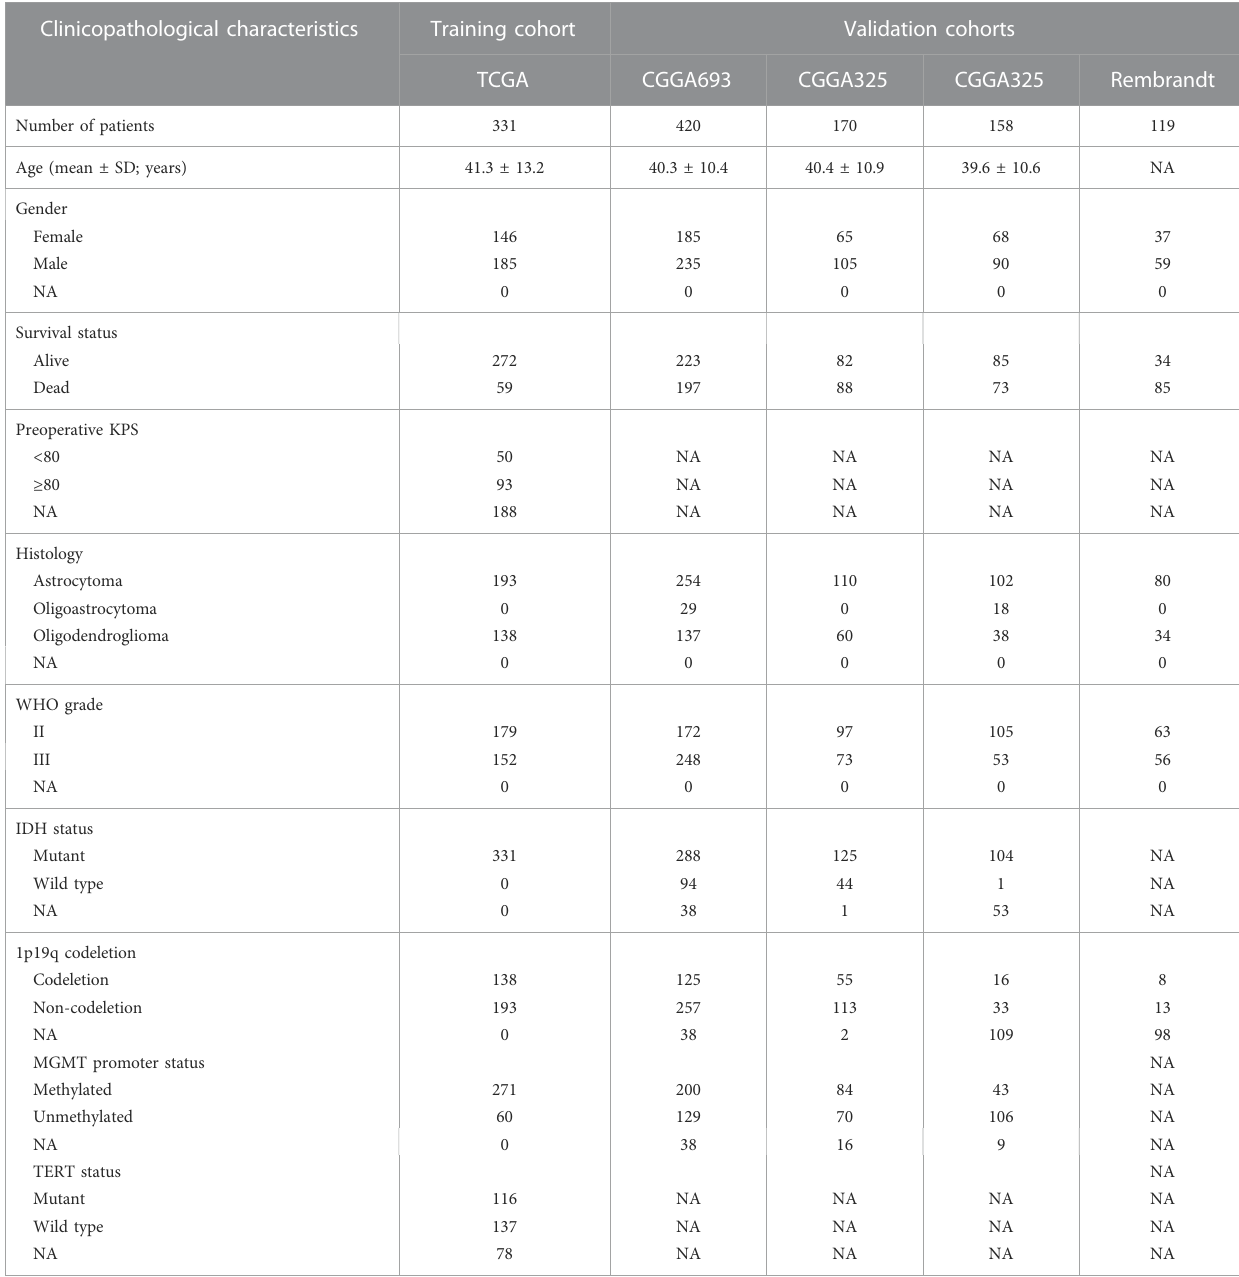
TABLE 1 Characteristics of glioma patients in training and validation